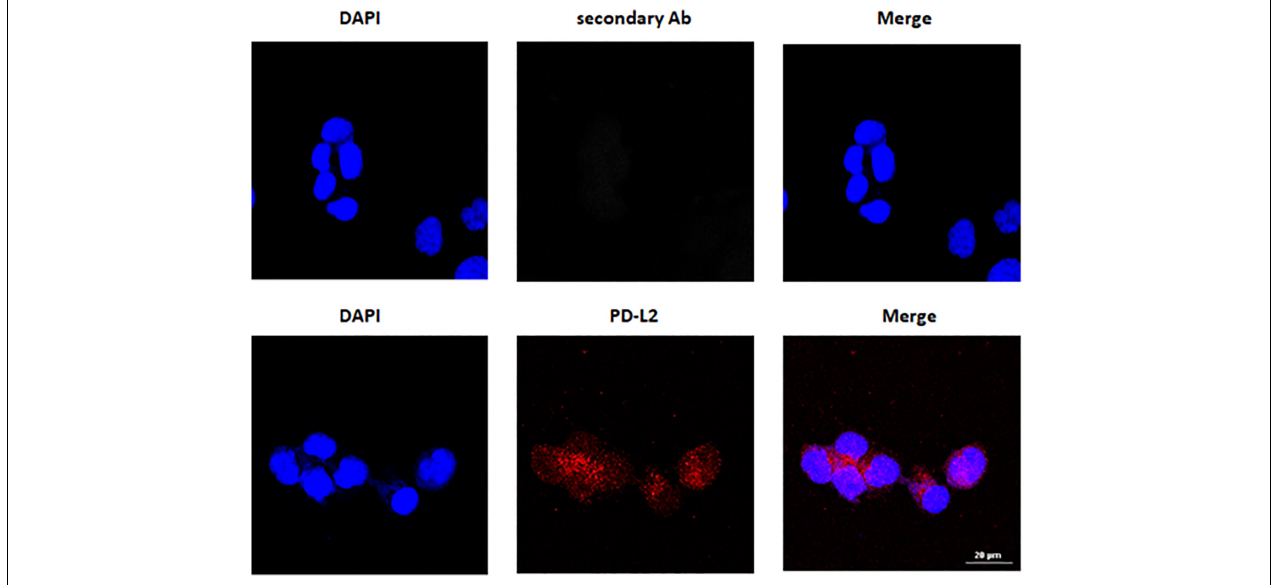
FIGURE 2 | PD-L2 cytoplasmatic expression in Ishikawa cells. Cells were fixed, permeabilized, and stained with anti-human PD-L2 antibody (Ab) followed by Alexa Fluor-594 secondary Ab. 4’,6-Diamidino-2-phenylindole (DAPI) was used to counterstain the nuclei. Calibration bar: 20 µ